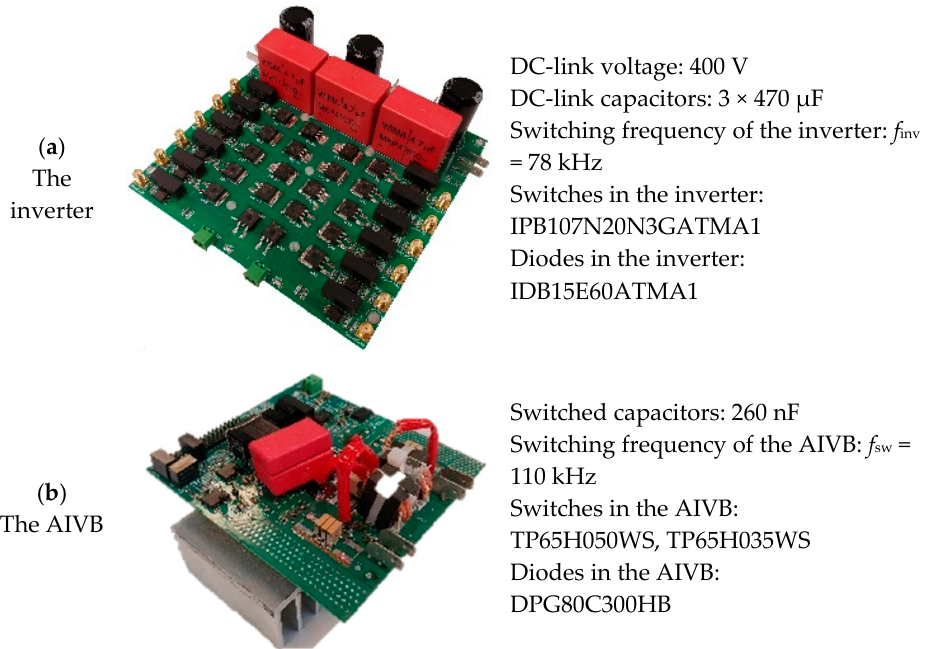
Figure 21. The output voltage ( u out [100 V/div]) and current ( i out [2 A/div]) of the inverter, as well as the voltage ( u source1 [100 V/div]) and current ( i source1 [2 A/div]) of DC power supply, connected to the C 1 DC-link capacitor; 10 ms/div.